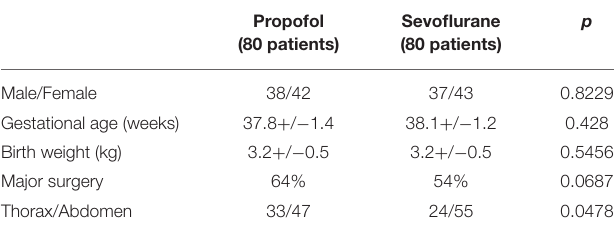
TABLE 2 | Baseline demographic characteristics of each group.